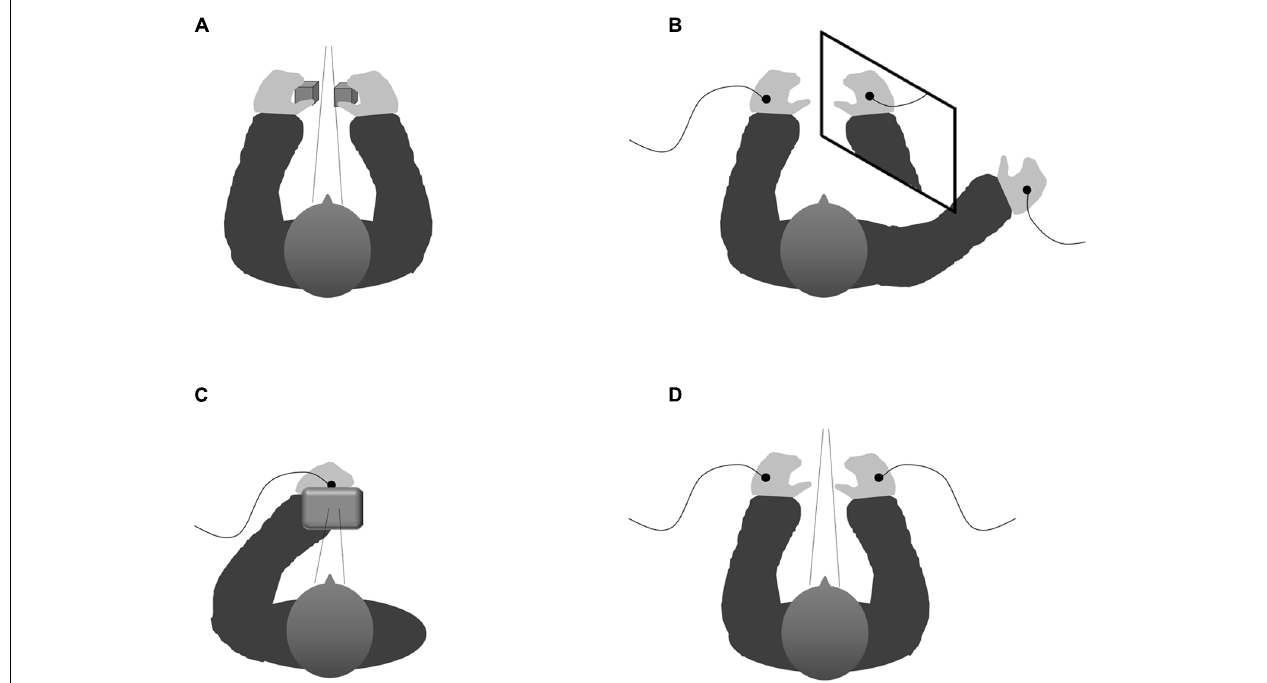
selective attention. (C) Experimental set-up implemented within our response-priming paradigm (with the right hand placed behind a screen; cf. Mast etal., unpublished manuscript) which represents a non-spatial tactile selection task where the direction of gaze is controlled for by presenting visual and tactile cues from roughly the same location. (D) Schematical depiction of the experimental set-up implemented within our tactile flanker paradigm (Wesslein etal., in press) notwithstanding the spatial dimension by keeping gaze direction constant by using a chin rest as well as presenting on fixation cross on the computer screen situated centrally in front of the participant on each trial. See text for